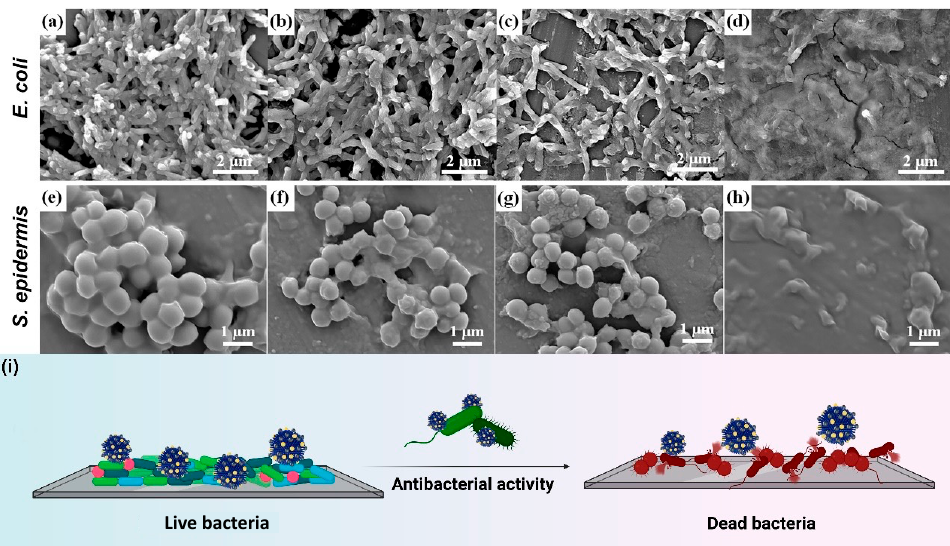
Figure 4. SEM images of E. coli ( a – d ) and S. epidermidis ( e – h ) after treatment of vancomycin ( a , e ), SiNPs-Van ( b , f ), SiNPs-Ag ( c , g ) and SiNPs-Ag-Van ( d , h ), and schematical illustration of the antibacterial activity ( i ).